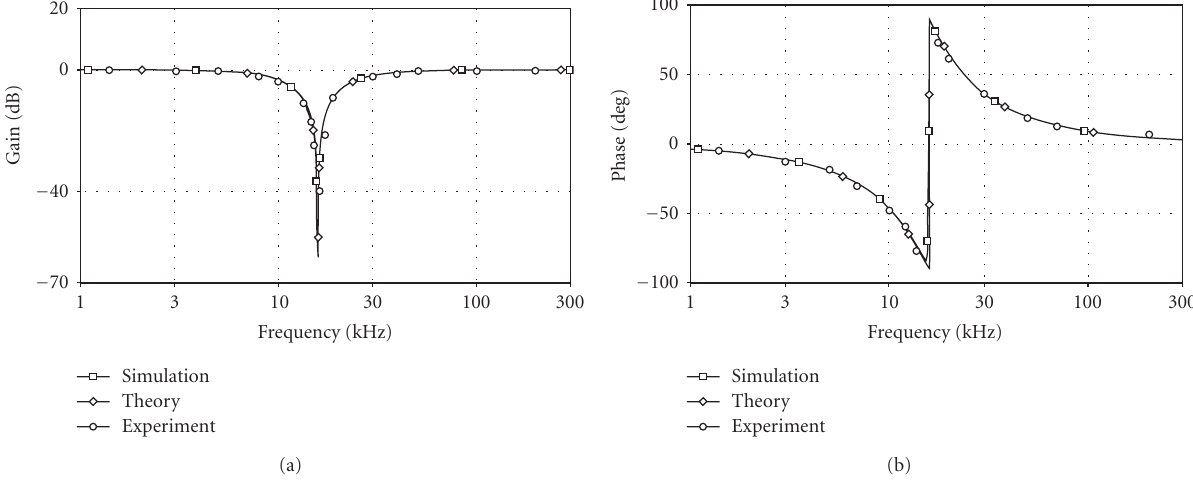
Figure 6: Frequency responses of the BS filter, (a) gain response and (b) phase response.